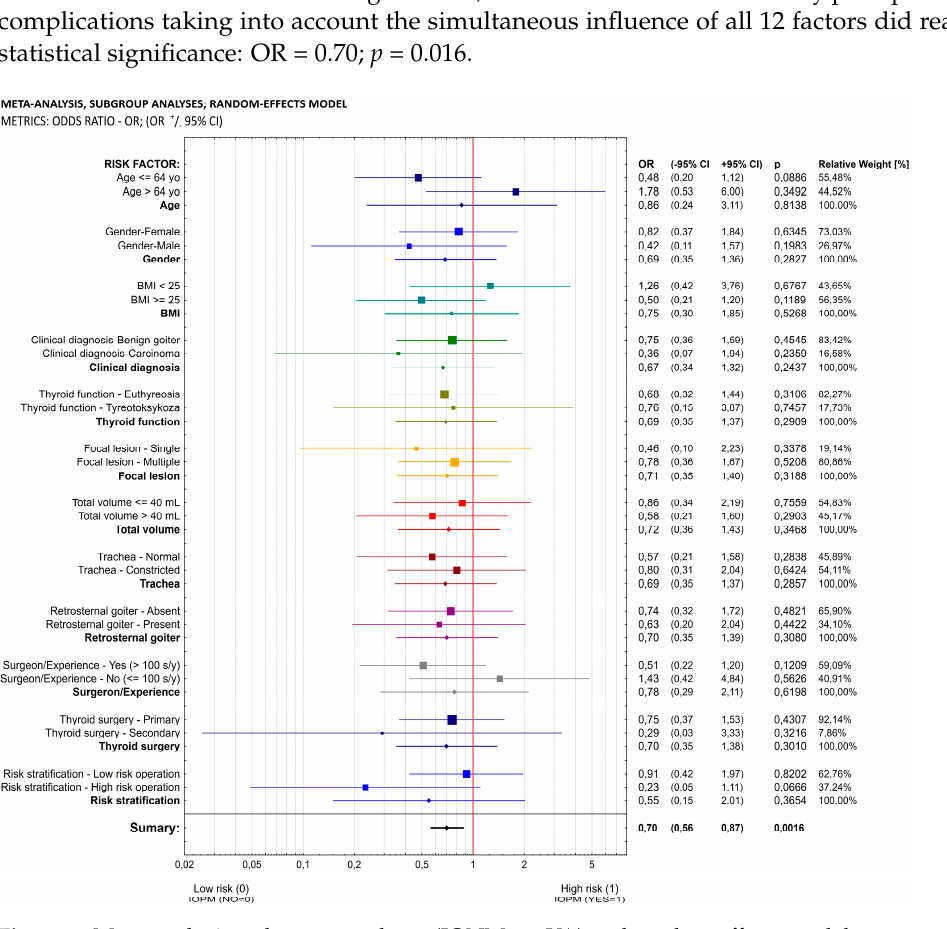
Figure 2. Meta-analysis, subgroup analyses (IONM vs. VA) and random effects model.